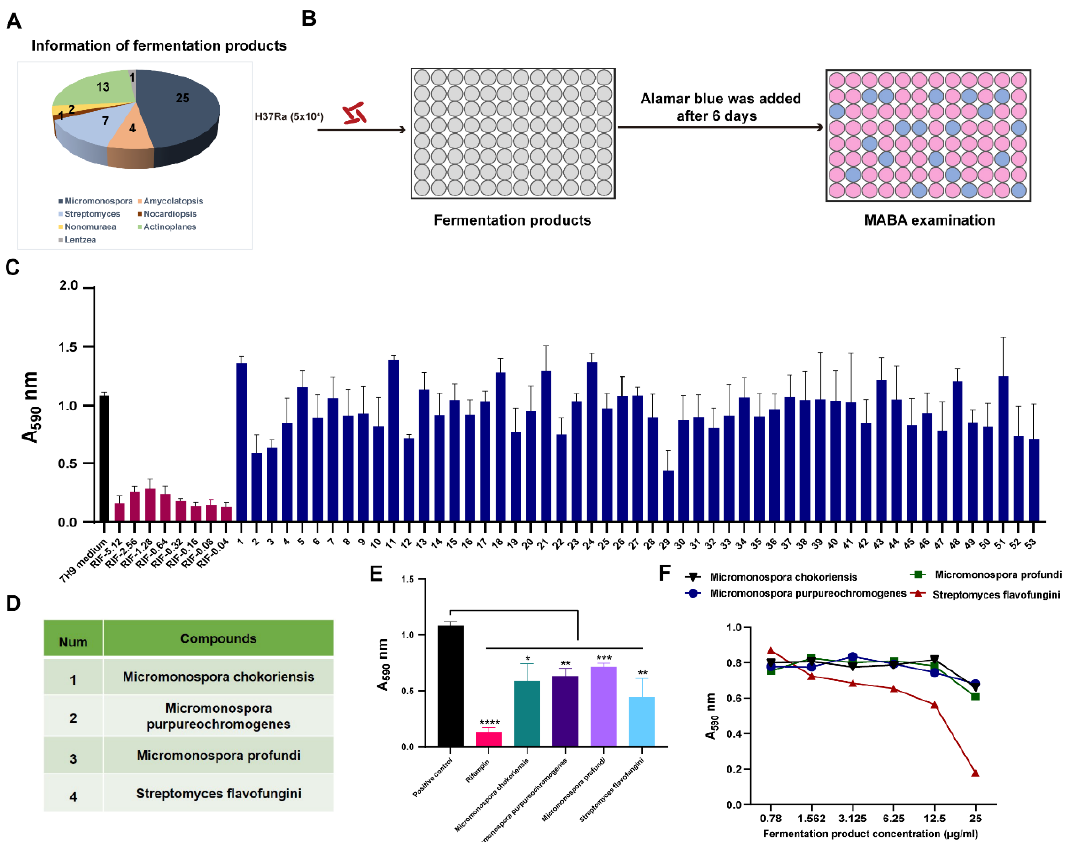
Figure 2. In vitro screening of fermentation products against M.tb H37Ra. ( A ) The distribution of each fermentation product in the natural microorganisms. ( B ) Schematic of screening each fer- mented product inoculated with a suspension of M.tb H37Ra in 96-well microplates for 7 days, with antibacterial effects determined using an Alamar Blue assay. ( C ) The anti- M.tb H37Ra effects of each fermented product. ( D , E ) Four fermentation products were selected with anti- M.tb activity, and ri- fampicin (RIF) was used as a positive control. ( F ) The determined MIC of selected fermented prod- ucts. Data presented as mean ± SEM. All experiments were performed in triplicate. The values of *, p < 0.05; **, p < 0.01; ***, p < 0.001; and ****, p < 0.0001 were considered statistically significant differ- ences.